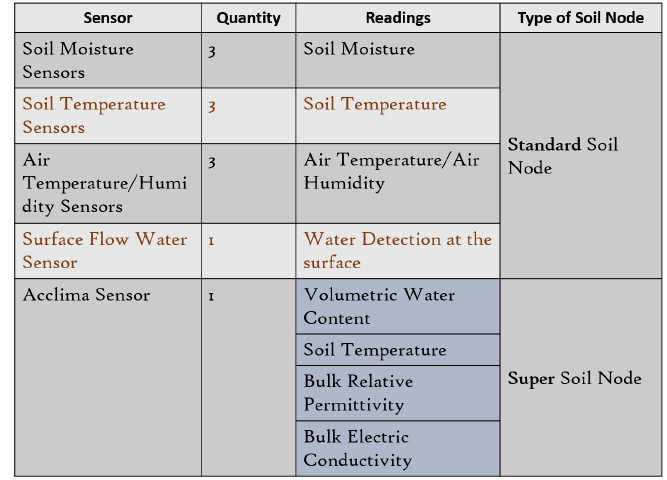
Figure 7. Sensor inputs on our soil nodes, mixing a large quantity of cheap Grove sensors with a small number of high-quality Acclima